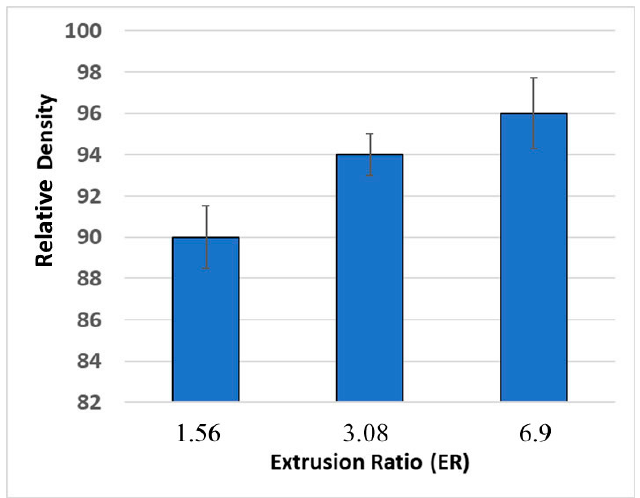
Figure 5. Relative density of the ZnSb samples extruded with different ERs.